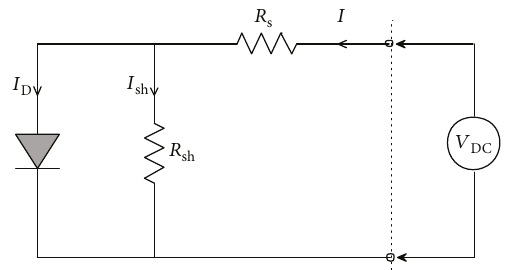
Figure 3: Equivalent circuit model of a practical solar cell with parasitic series and shunt